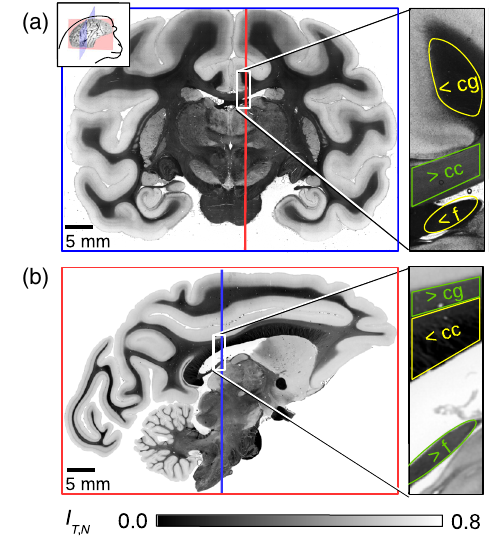
FIG. 2. Normalized transmittance images I of a coronal (a) T;N and a sagittal (b) vervet brain section, obtained from a 3D-PLI measurement with 1 . 33 μ m pixel size (the fiber orientation map in Fig. 1 is obtained from the same coronal brain section). For reference, the coronal (sagittal) section plane is indicated by a vertical blue (red) line in the respective other brain section. The enlarged areas on the right show anatomical brain regions with predominantly in-plane (out-of-plane) nerve fibers in green (yellow). Within each section, in-plane nerve fibers have larger transmittance values than out-of-plane fibers. cg ¼ cingulum, cc ¼ corpus callosum, and f ¼